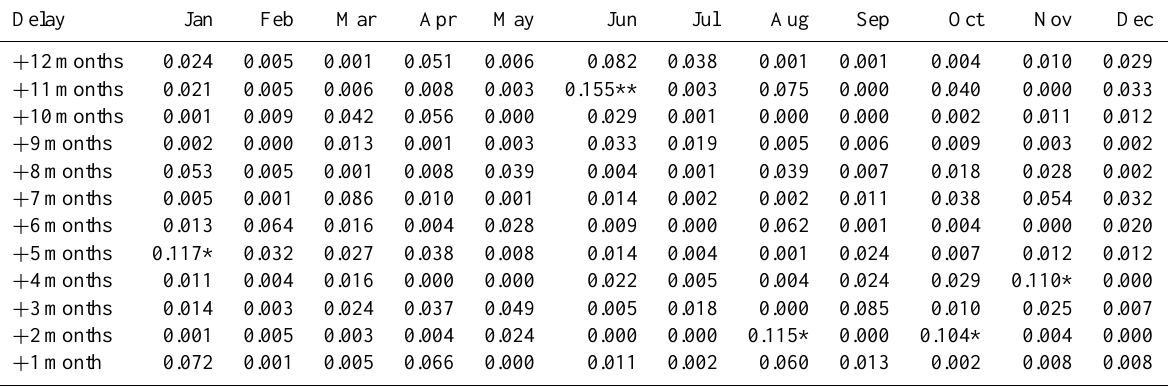
Table 2. Cross-correlation between PNA index and precipitation. Delay Jan